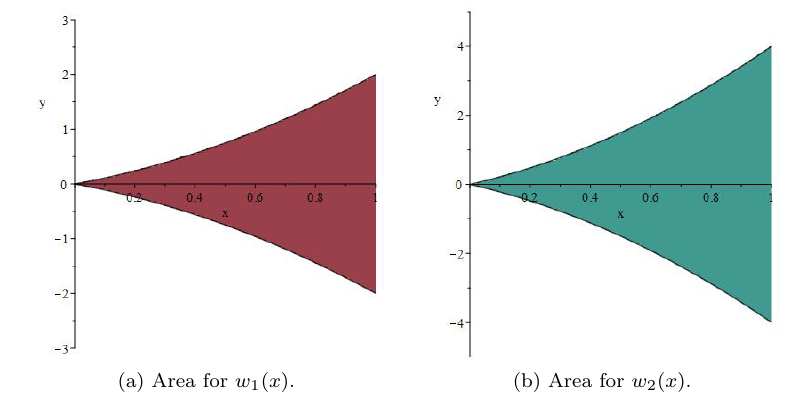
Figure 2. Localization of solutions w 1 ( x ) and w 2 ( x